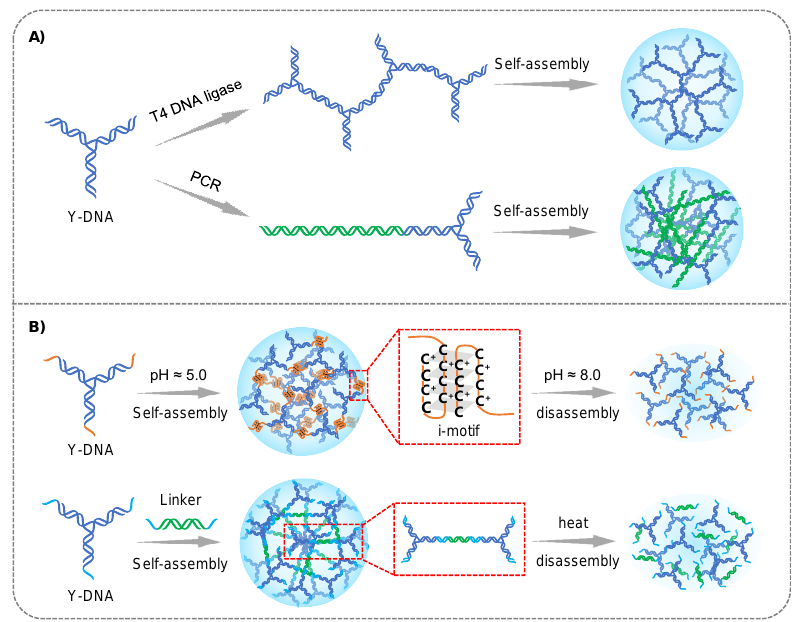
Figure 1. The preparation strategies of branched DNA hydrogels: ( A ) enzyme-mediated assembly. ( B ) non-enzyme-mediated assembly.